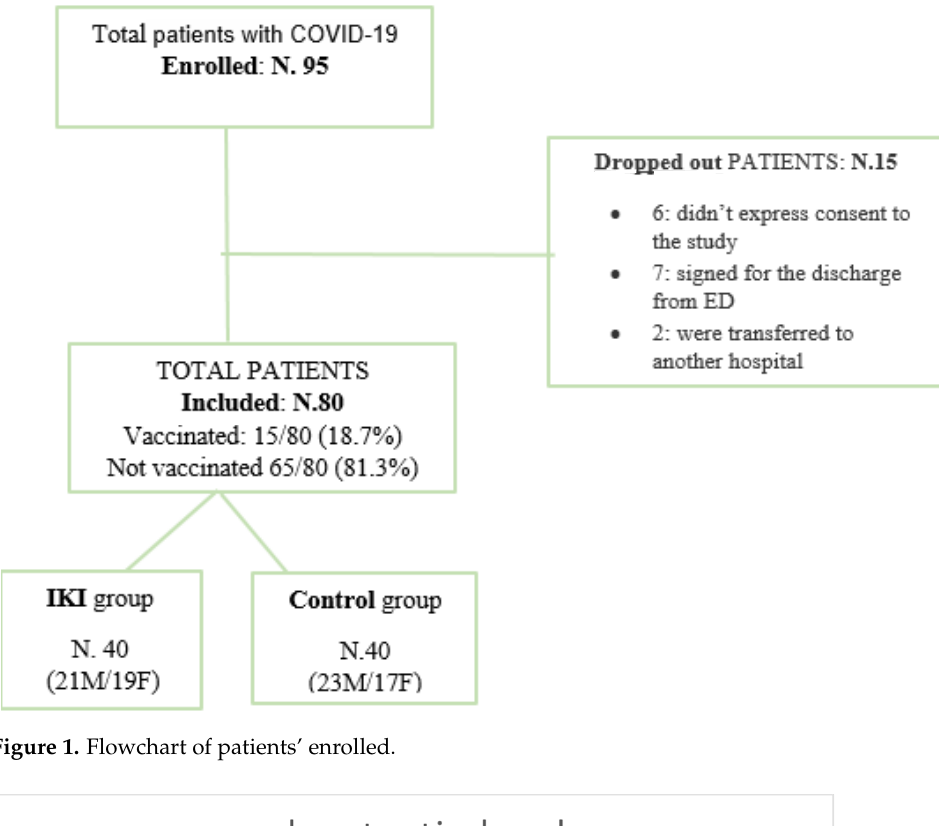
Figure 1. Flowchart of patients’ enrolled.